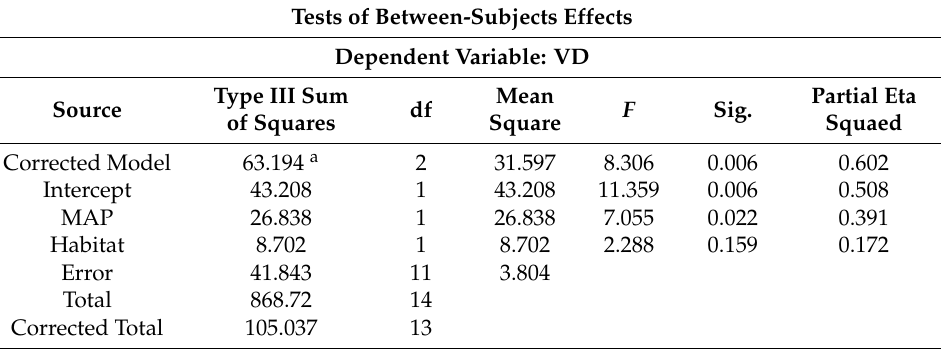
Table A4. The result of ANCOVA between vein density (VD) and MAP in hillside and valley